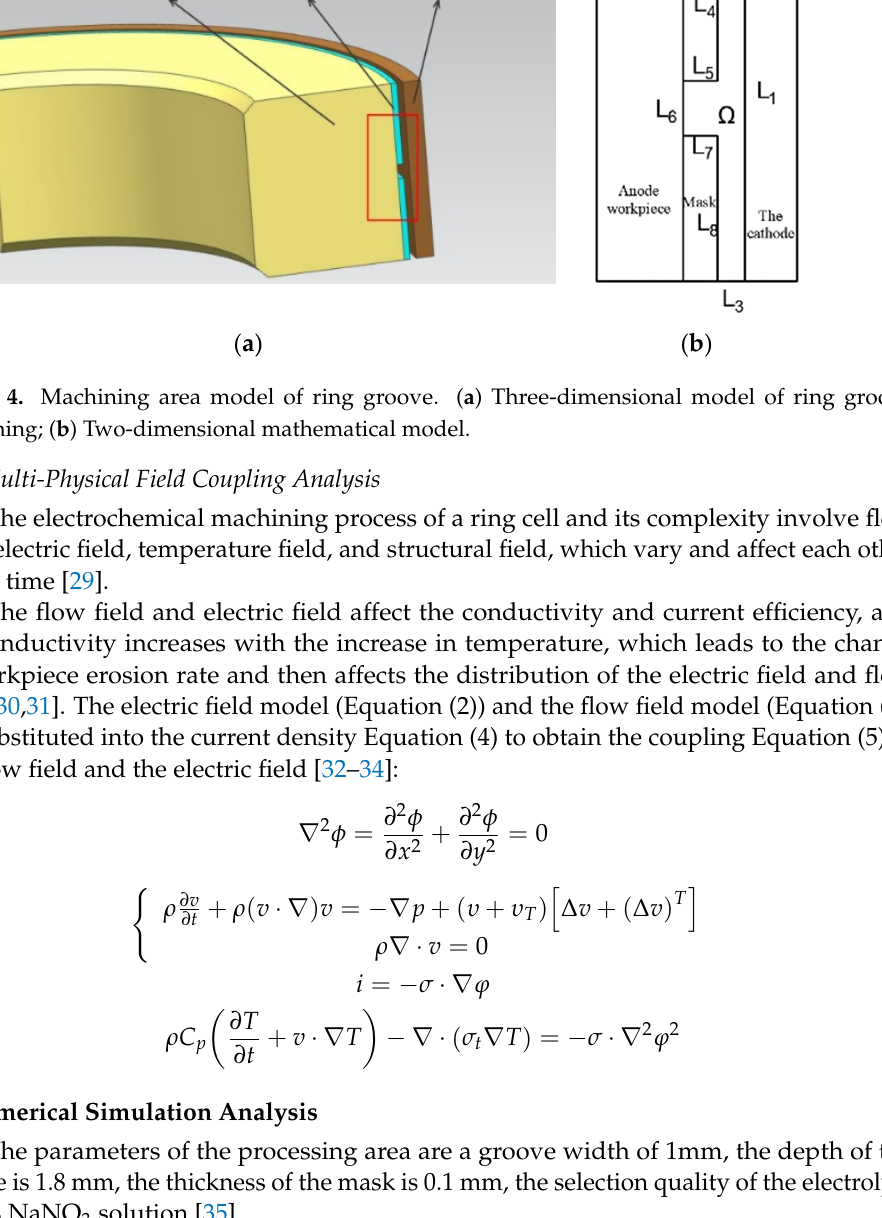
( b ) Figure 3. Annular narrow slot geometric model. ( a ) Integral structure of winding wheel; ( b ) Narrow